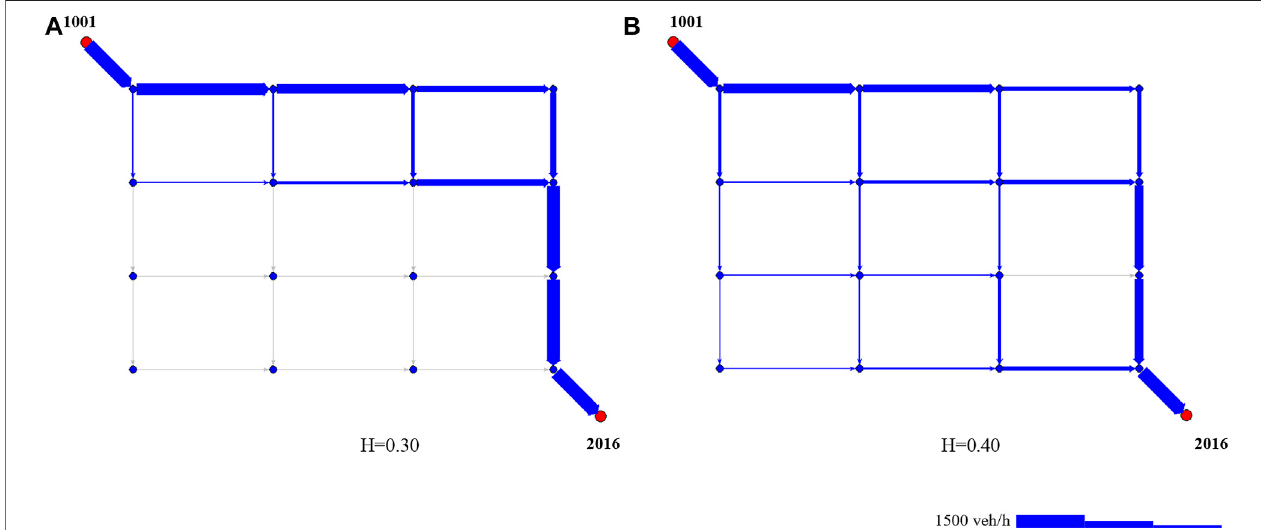
FIGURE 6 | Link considered in the implicit loading procedure for values of H =0.30 (A) and H =0.40 (B) .